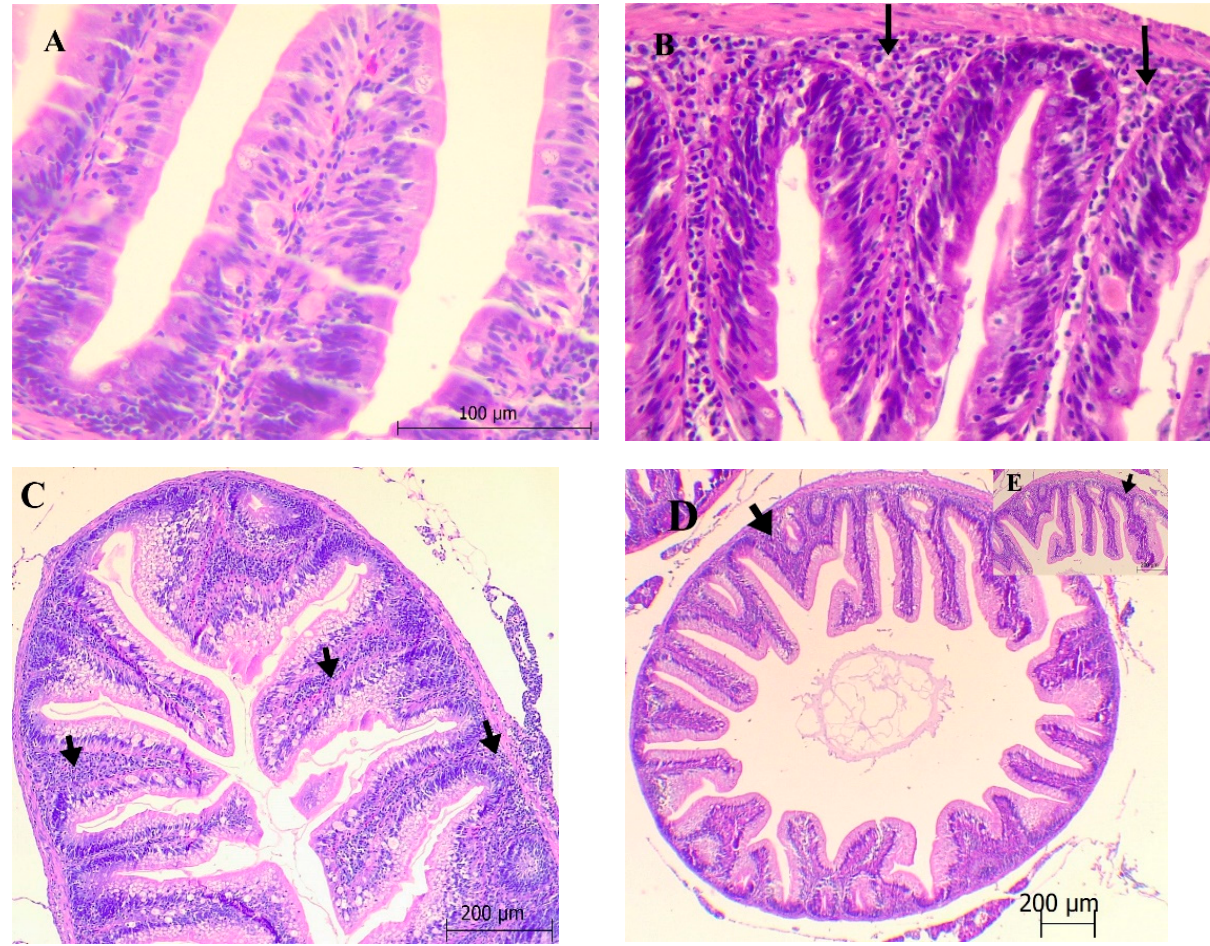
Figure 2. Histological preparations of intestine (ematoxylin-eosin staining) of fingerling common carp after feeding experimental diets with graded levels of neroli oil (0–1.5%) for 60 days. ( A ) Lamina propria cell infiltration and hyperemia in the submucosa (NO 0.25 ). ( B ) Cell infiltration (black arrows) in the submucosa (NO 0.50 ). ( C ) Cell infiltration in the lamina propria and submucosa (black arrows) and hyperemia in the submucosa (NO 1 ). ( D , E ) Lamina propria, severe cell infiltration in the submucosa (black arrows) and hyperemia (NO 1.5 ).